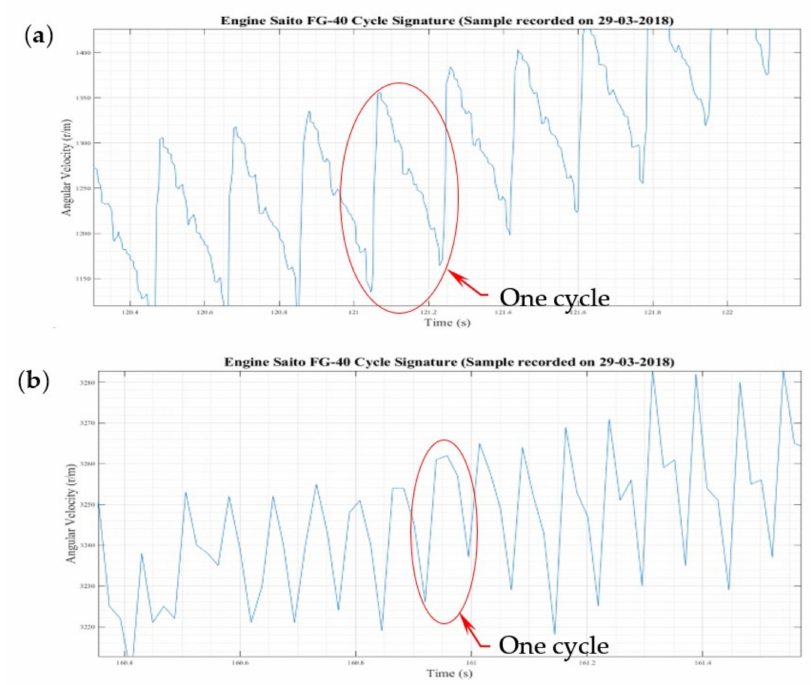
Figure 5. Fine details of speed evolution of the Saito FG-40 engine ( a )—1250 r/m; ( b )—3240 r/m.